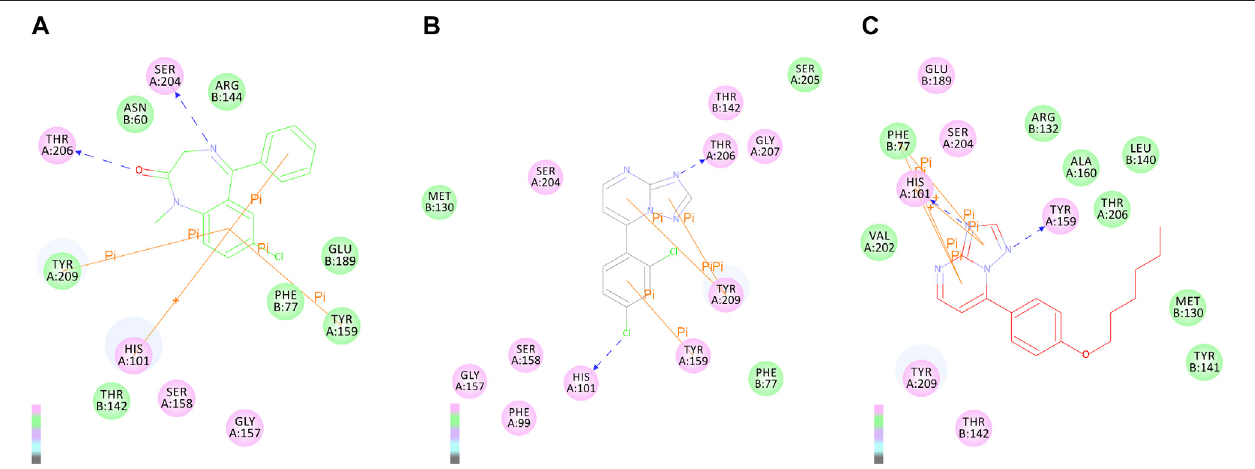
FIGURE 3 | 2D binding modes of diazepam (A) , compound 4e (B) , and 6d (C) in the BZD-binding pocket of the GABA A receptor ( α 1 β 2 γ 2).